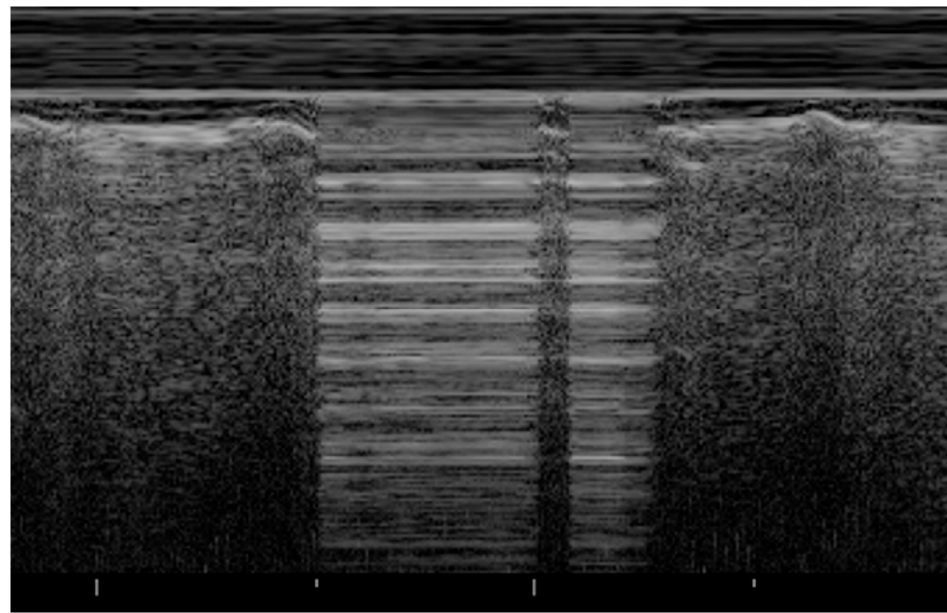
Figure 3. Pneumothorax: evidence of lung point, i.e., the transition point from the typical LUS pattern of PNX to the normal one.